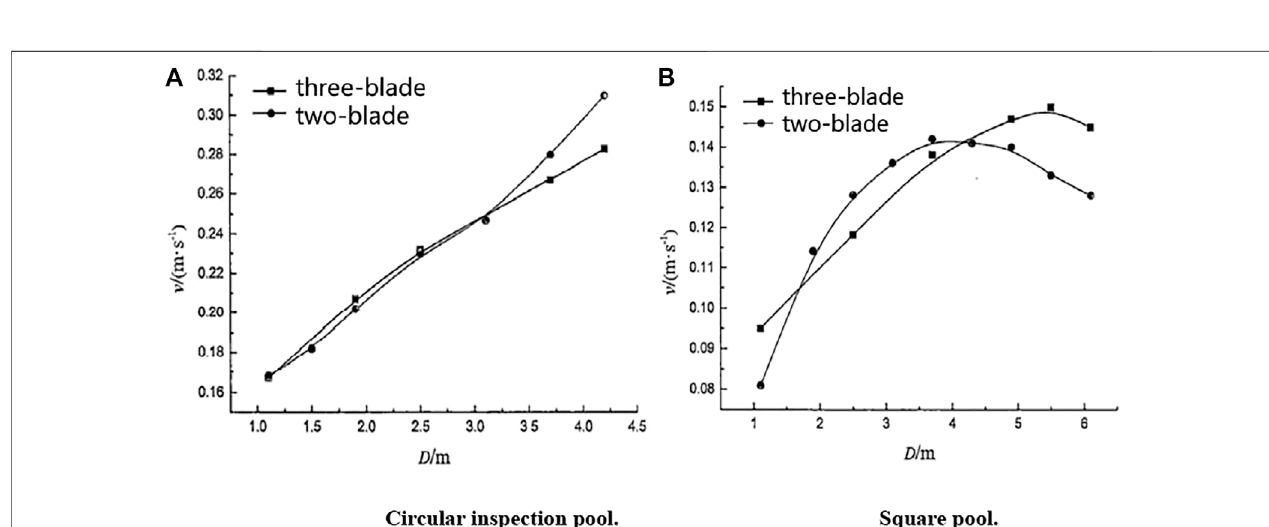
FIGURE 7 | Comparison of the average velocity in the pool of three-blade and two-blade submersible mixer.